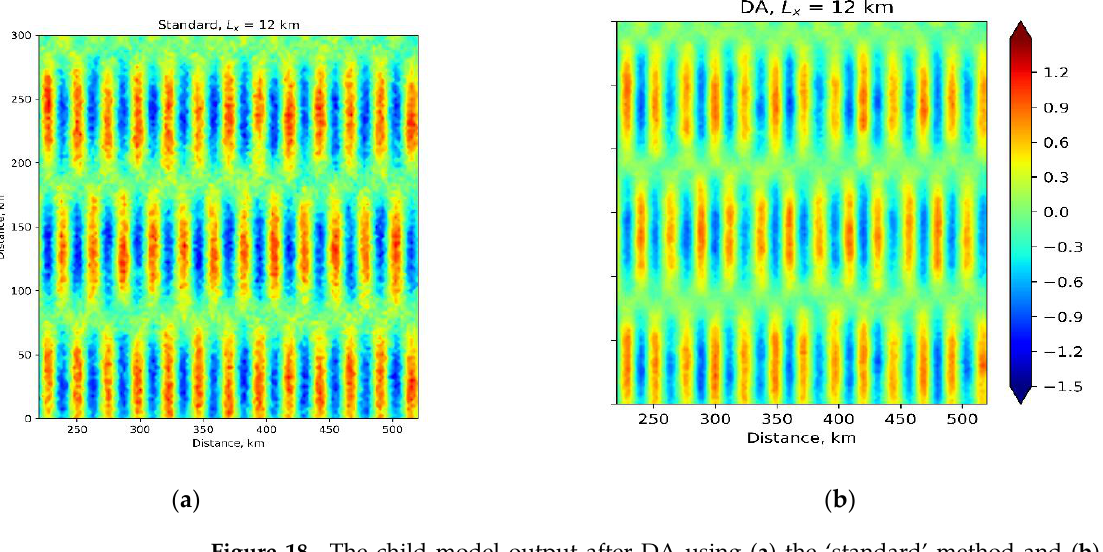
Figure 18. The child model output after DA using ( a ) the ‘standard’ method and ( b ) the data assimilation with stochastic – deterministic downscaling (NDA). The NDA produces less noise.